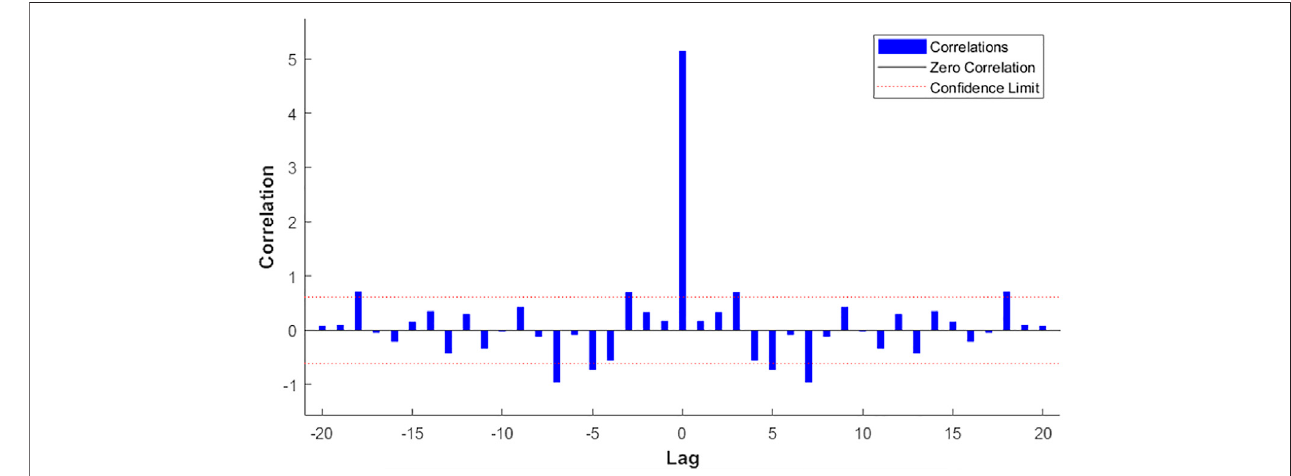
FIGURE 5 | Error autocorrelation.